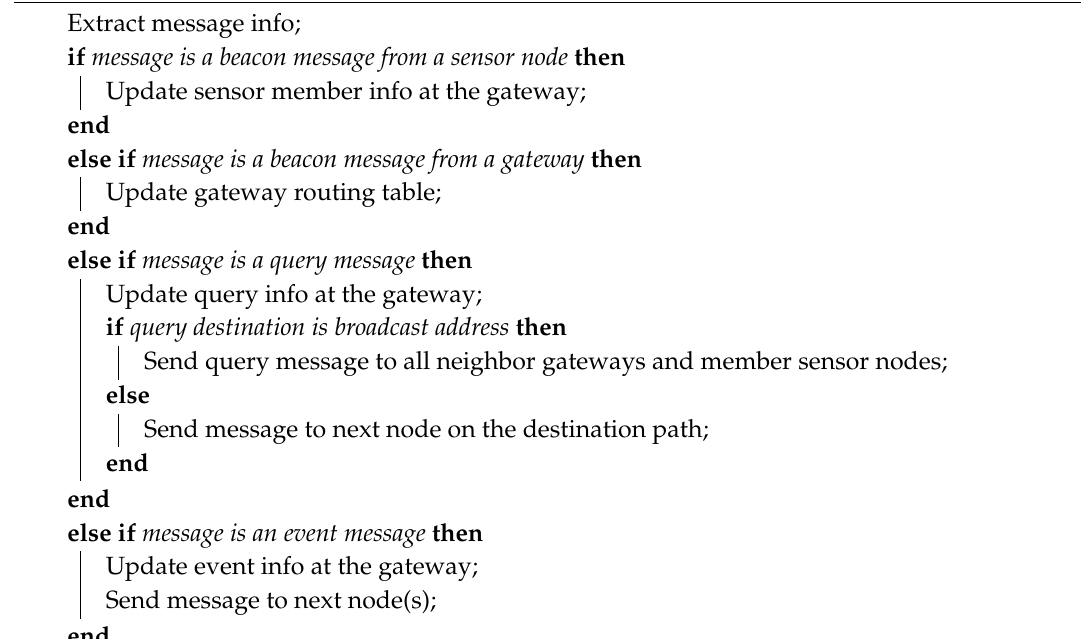
Algorithm B1: Processing New Message Algorithm at a